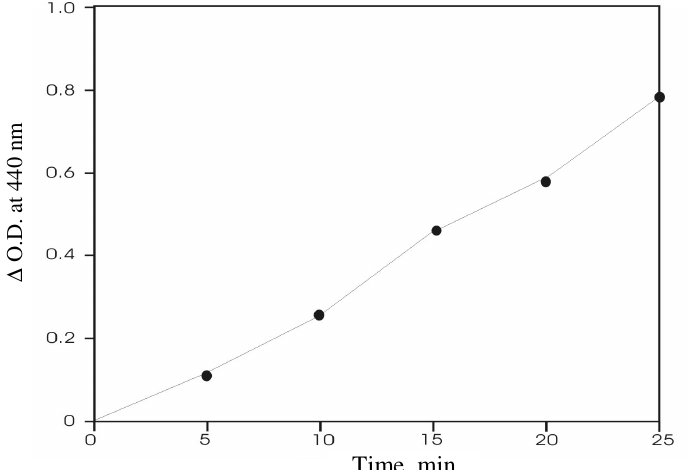
production and sunlight exposure of 2